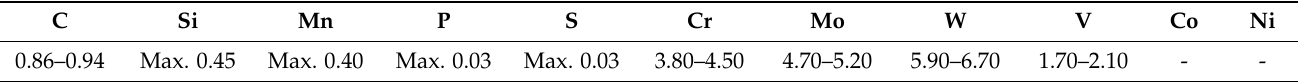
Table 1. Chemical composition of